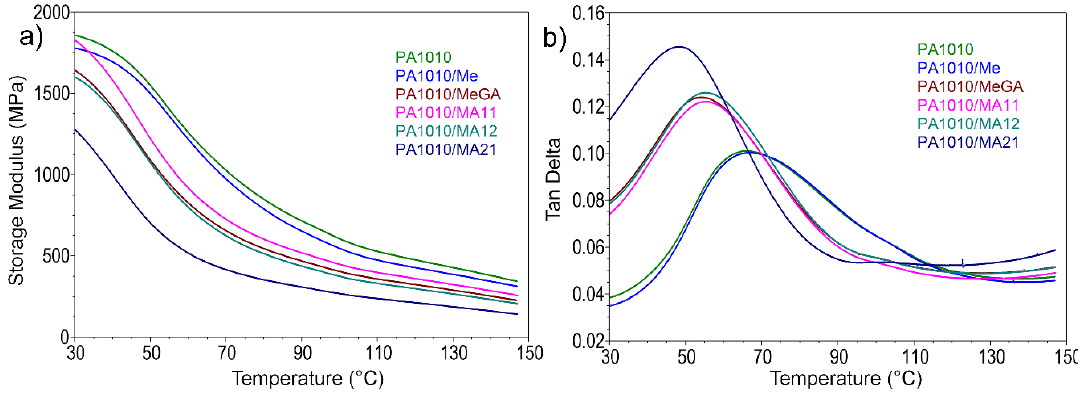
Figure 7. Storage modulus ( a ) and Tan δ ( b ) of PA1010 composites vs. temperature.